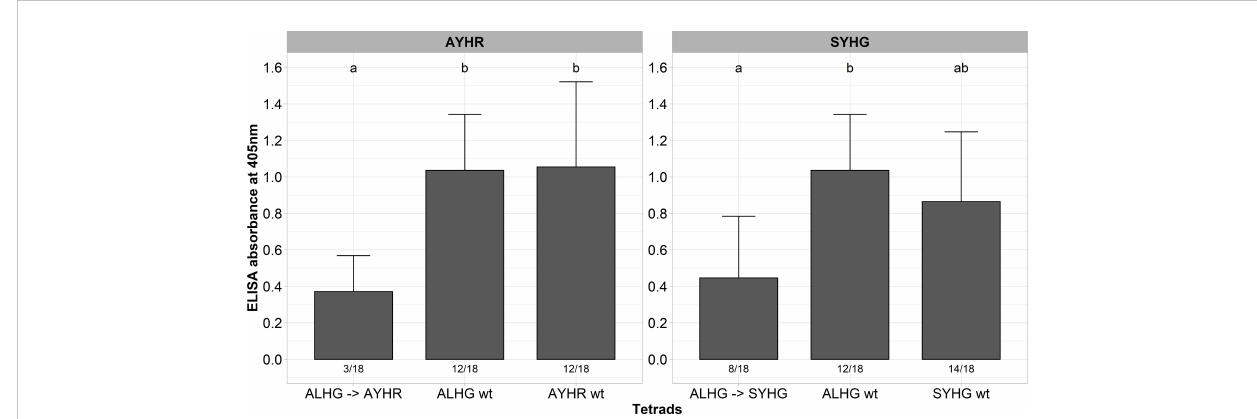
FIGURE 3 ELISA absorbance values for BNYVV measured in lateral roots of plants from a susceptible sugar beet genotype (N=18). Plants were inoculated with the wild type clone (ALHG wt) and with different BNYVV variants in which either the tetrad ALHG of the A type P25 was mutated (ALHG → AYHG/ SYHG) or the whole ORF from A type P25 was replaced by an ORF encoding a P25 from a B (AYHR wt) or P type (SYHG wt). Lateral roots were harvested 6 weeks after inoculation. The numbers below each bar indicate the infection rate (infected/inoculated). Mean values were calculated using only infected plants, whereas all values were averaged when no plant was infected. Error bars indicate standard deviation. The healthy controls are not shown because the absorbance values were zero. The statistical analysis was done separately for AYHR (left) and SYHG (right) with the Dunnett post hoc test. Signi fi cant differences are indicated by small letters (p <